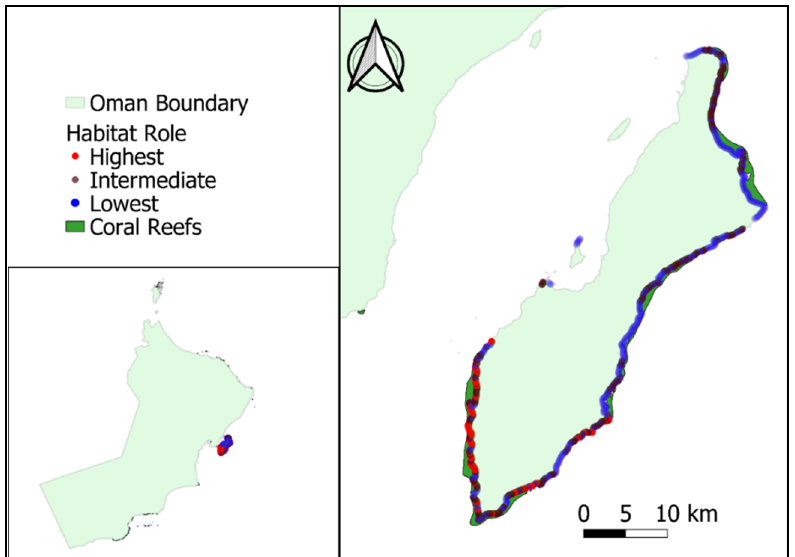
Figure 5. Natural habitat contribution to coastal protection for Masirah’s Island, Sultanate of Oman.